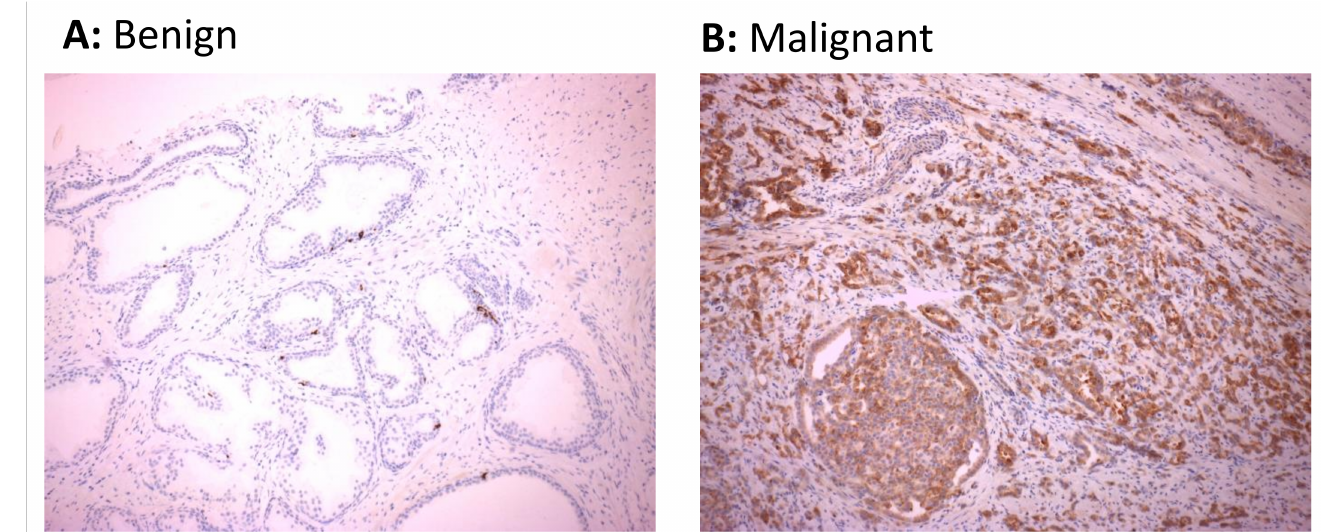
Figure 4. Expression of HERV-K Gag protein in cancerous regions of prostate tissue sections. HERV-K Gag protein was detected in sections of matched malignant and benign regions of formalin-fixed paraffin-embedded prostate biopsy tissue from 18 males with prostate cancer by immunohistochemistry. Immunohistochemical images from benign prostate tissue ( A ) or malignant prostatic adenocarcinoma ( B ) regions of the prostate showing negative and positive staining for HERV-K Gag protein from one representative individual are